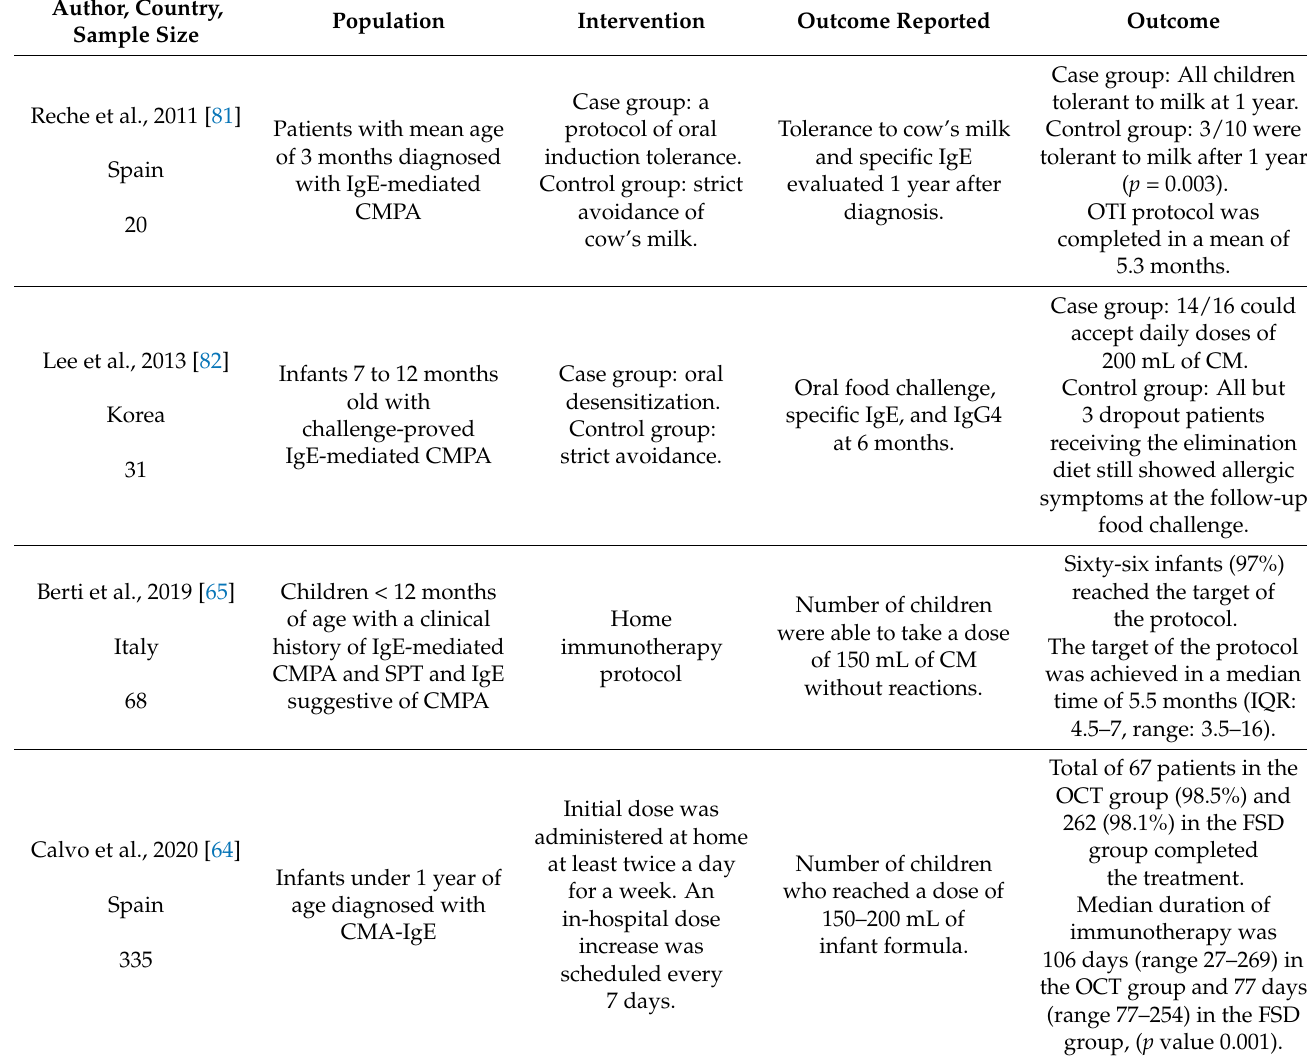
Table 5. Studies assessing early introduction of milk using oral immunotherapy protocols in young